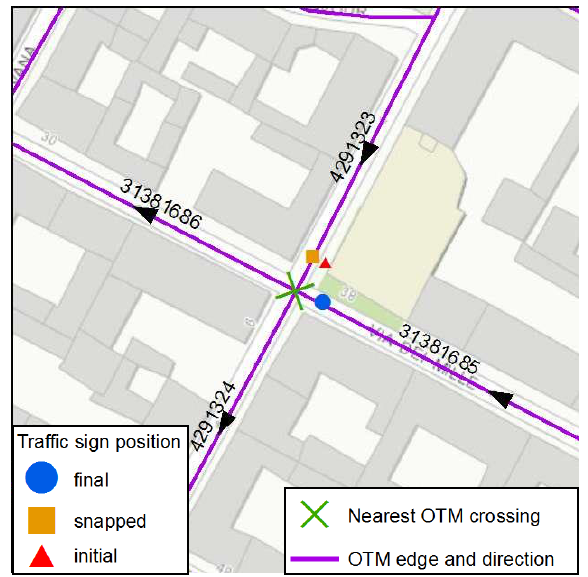
Figure 5. "Go straight or turn left" traffic sign positioning exploiting road network properties